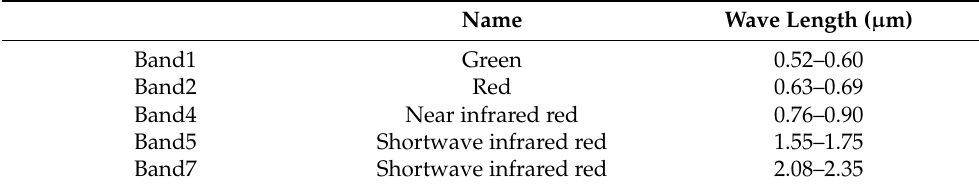
Table 1. Landsat bands.